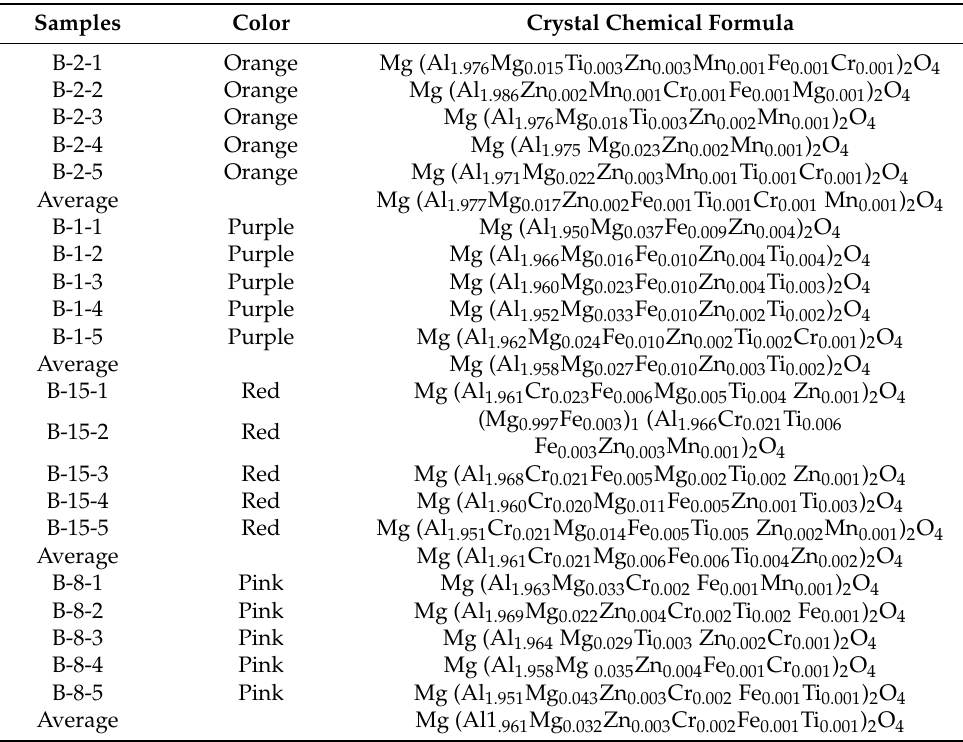
Table 4. Molecular formula of Mogok spinel samples from